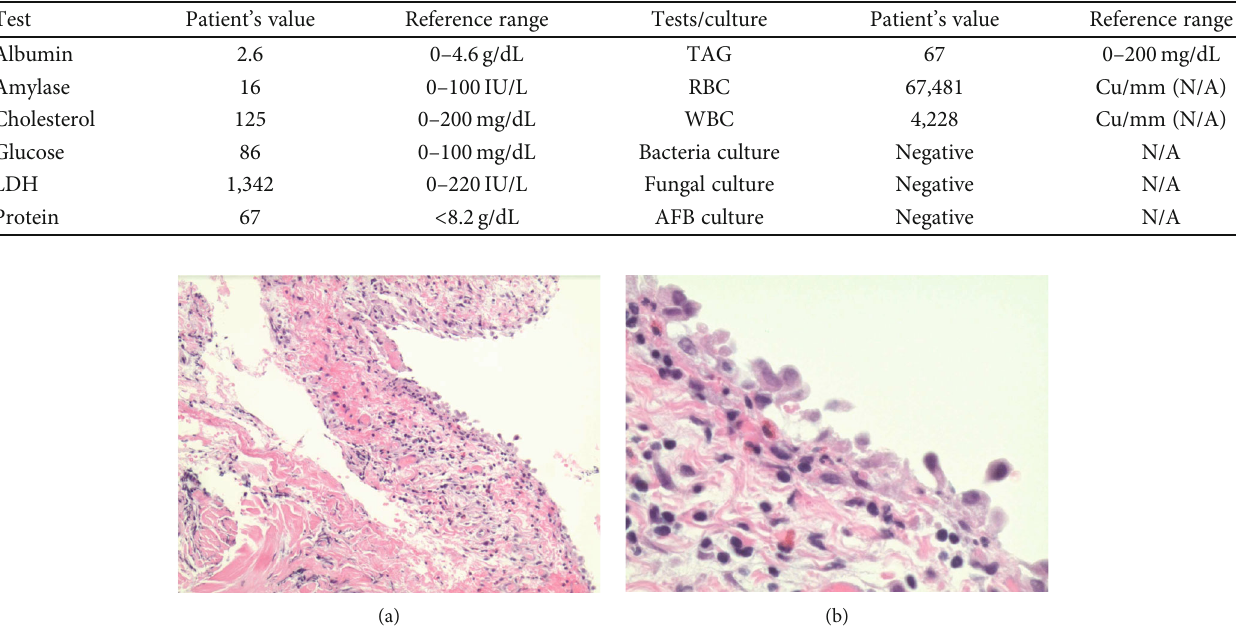
Table 2: Fluid analysis consistent with in fl ammatory pericarditis.